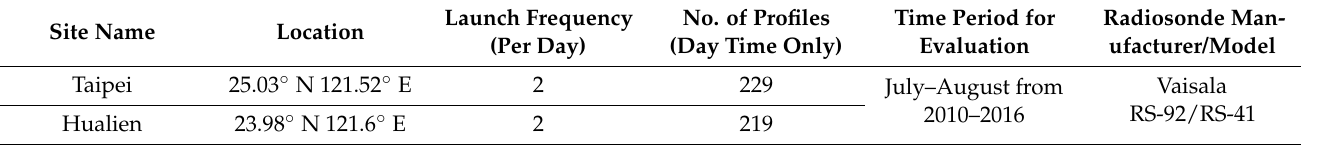
Table 1. Information related to the radiosonde observations used to evaluate the AIRS thermody- namic